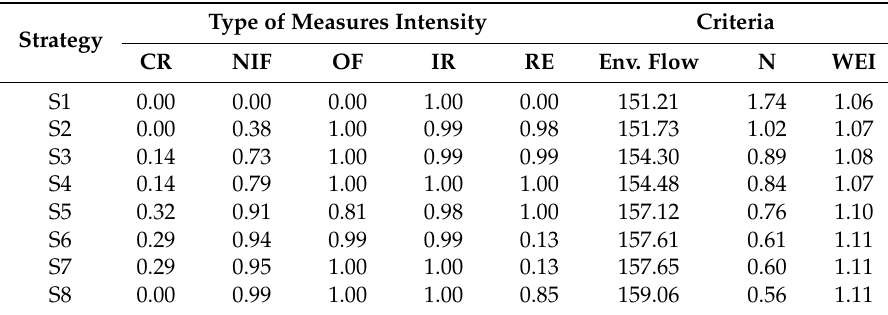
Table 4. Pareto PoMs obtained for the N, WEI and Environmental flow criteria for the Danube catchment, considering the agriculture related correction measures (CR: crop practices, NIF: N fixing, OF: optimum fertilization, IR: irrigation efficiency, RE: water reuse in industry). Type of Measures Intensity Criteria Strategy CR